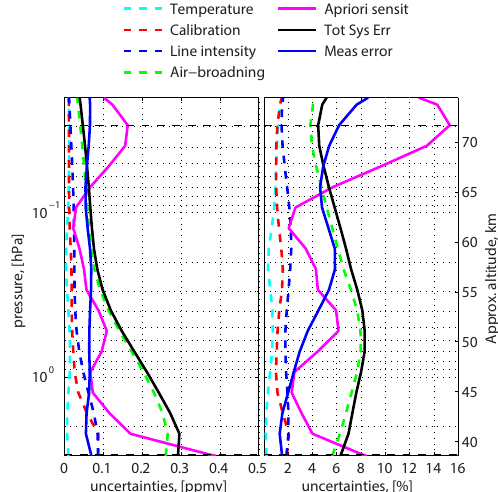
Figure 5. Error estimations of the BAS-MRT O 3 -retrieval: The black solid line shows the total systematic error, which is the root- sum-square of the dashed lines. The blue solid line is the random measurement error. The magenta solid line is the a priori sensitiviy. Dashed horizontal black lines indicate the upper / lower limit of the 0.8 measurement response. Left panel: uncertainties in ppmv repre- senting all times. Right panel: uncertainties in % of midnight O 3 -